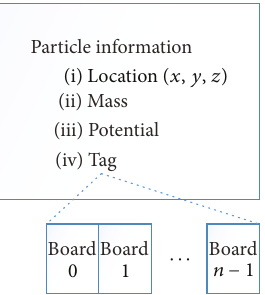
Figure 10: The data structure of particle information.